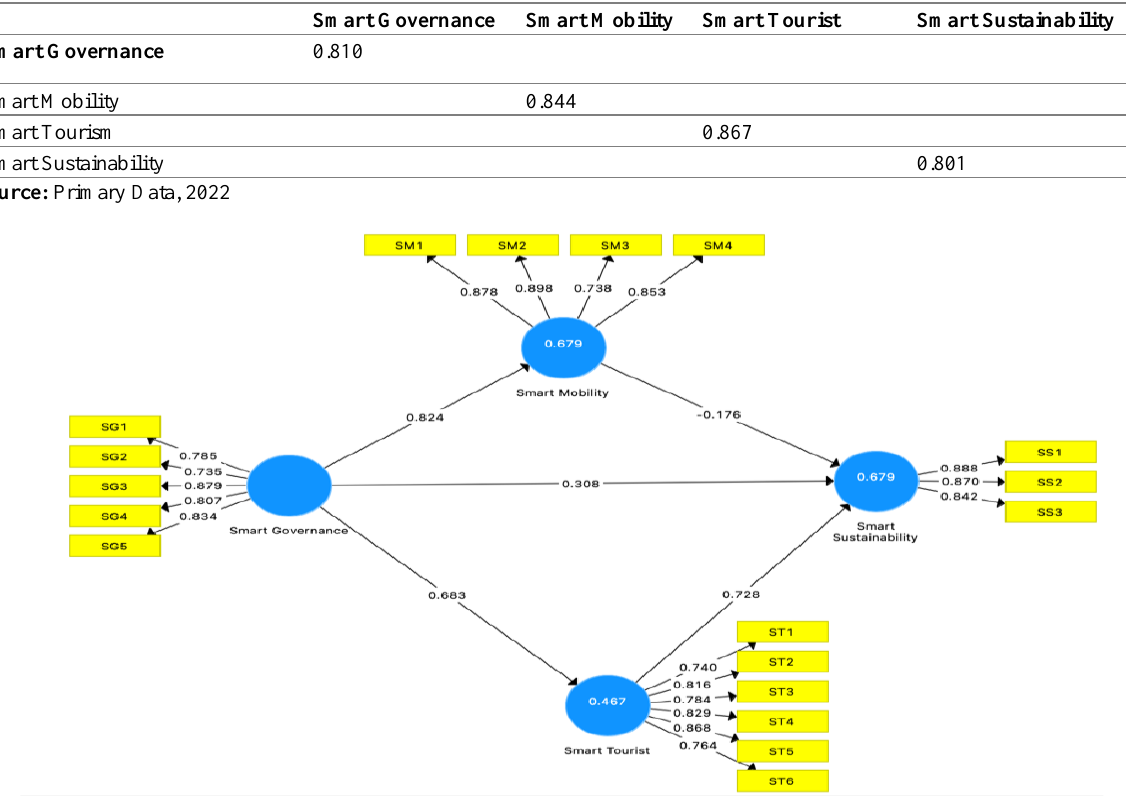
Figure 1: Validated structural model; Source: Primary Data,